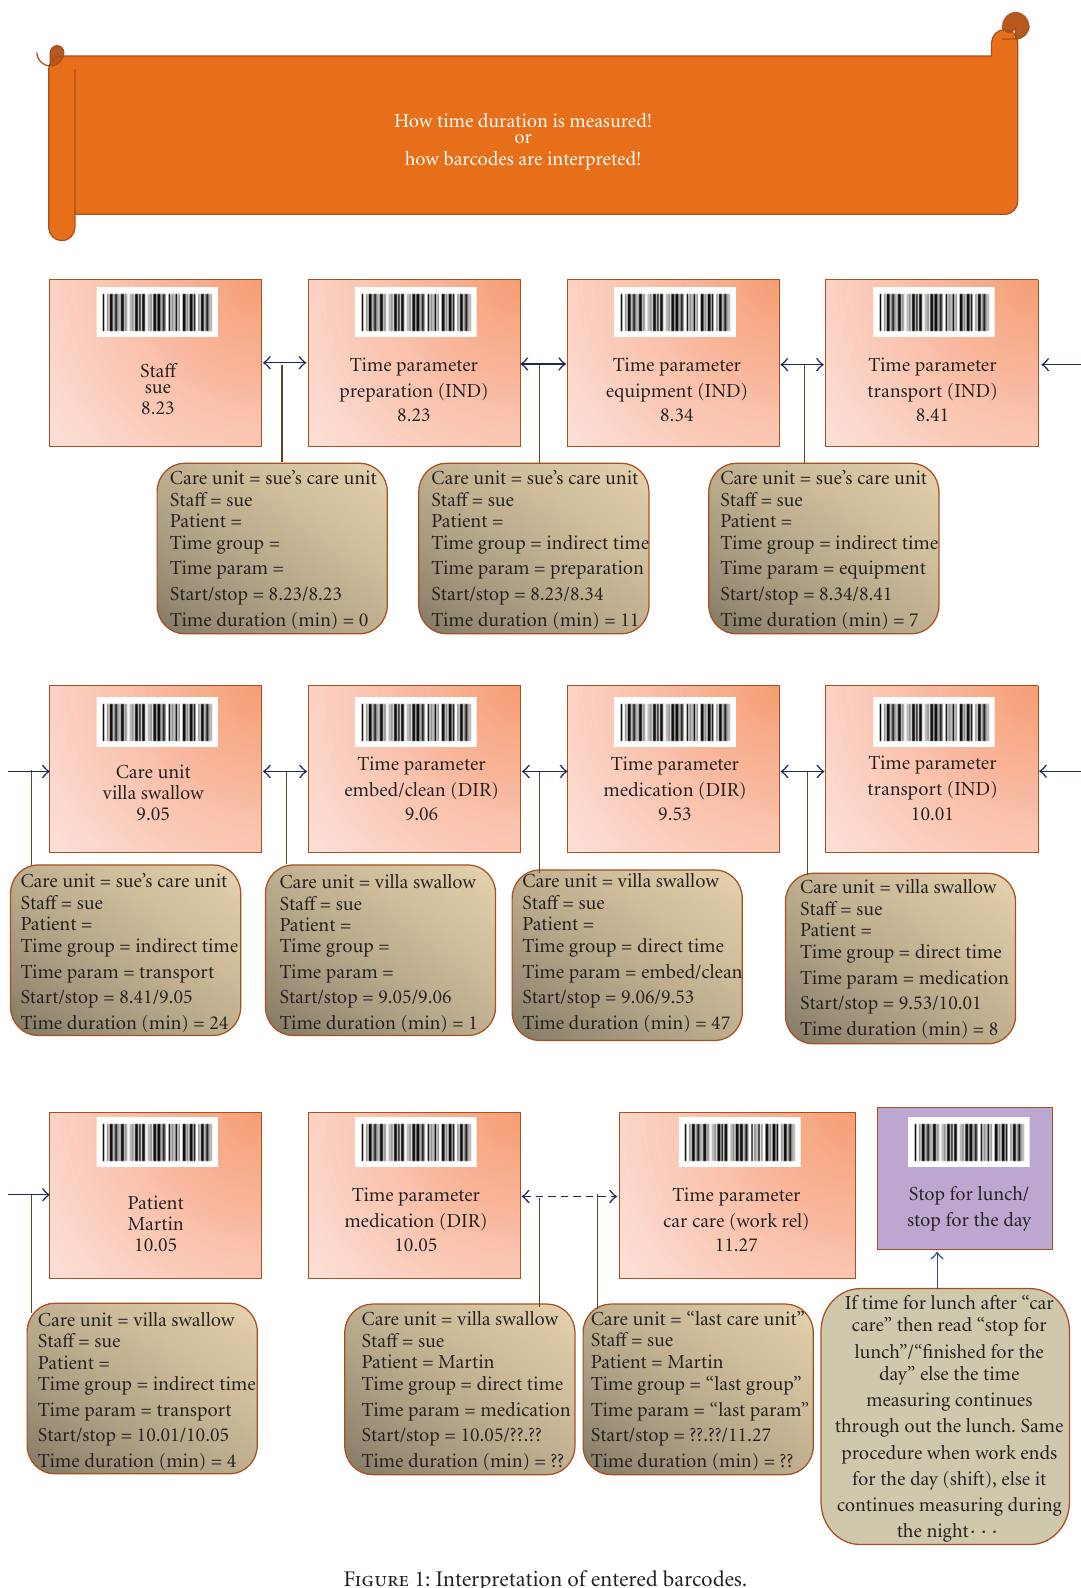
Figure 1: Interpretation of entered